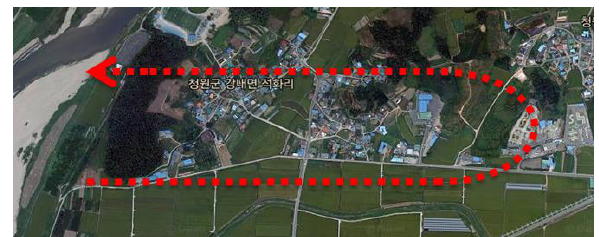
Figure 10. Test field and flight path